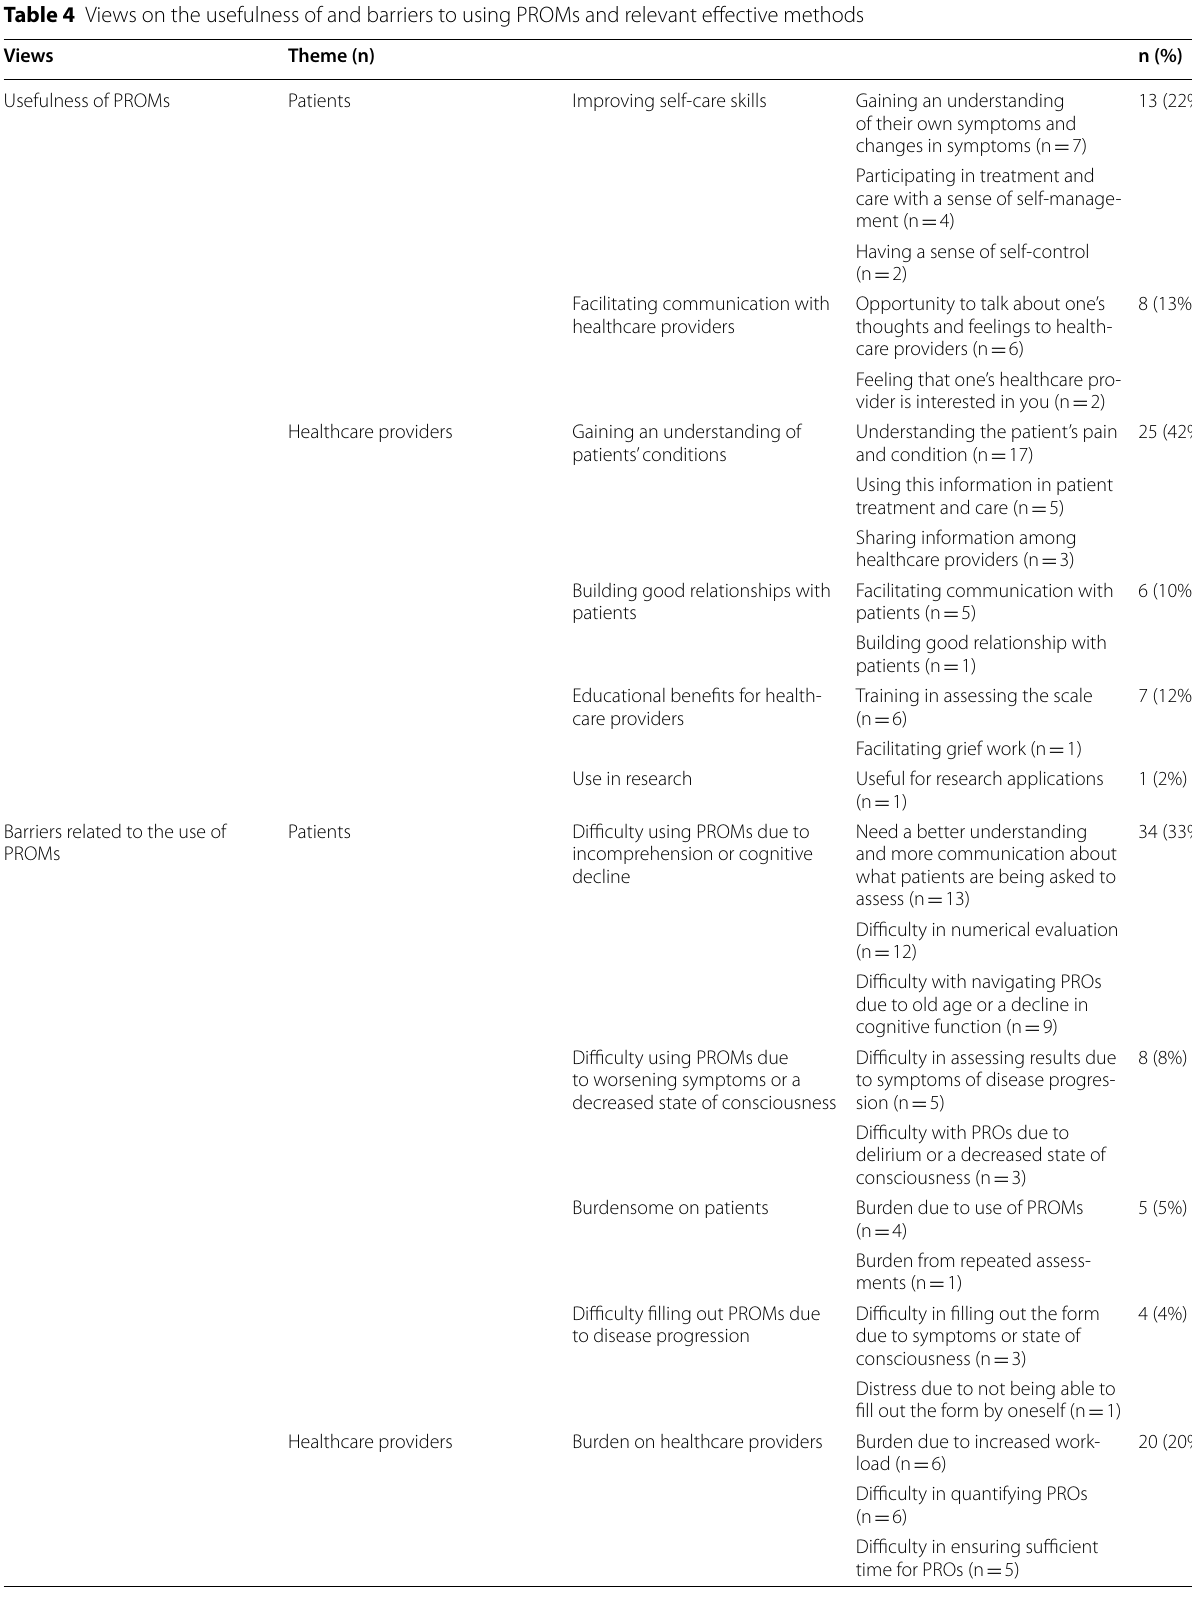
Table 4 Views on the usefulness of and barriers to using PROMs and relevant effective methods